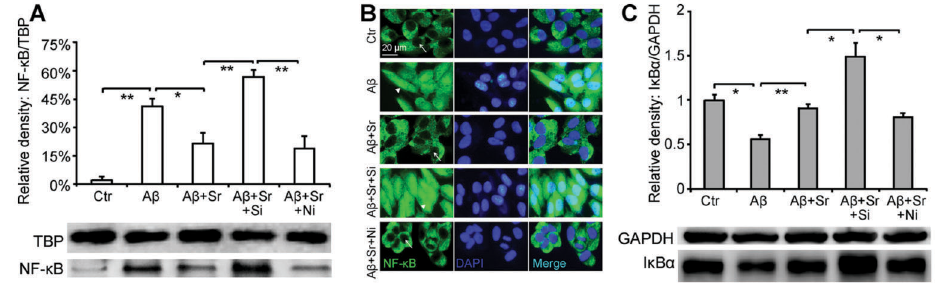
Figure 6. Detection of NF- k B/p65 and I k Ba expression. A , Western blot analysis of NF- k B/p65 expression in the nucleus. B , Immunofluorescence images for nuclear translocation of activated NF- k B/p65 subunit. C , Western blot analysis of I k Ba expression. Exposure to OA b induced a significant increase of NF- k B/p65 protein level in the nucleus and markedly increased nuclear NF- k B/p65 staining. In addition, the protein level of I k Ba was decreased in OA b -stimulated cells. SRT1720 significantly abrogated the effect of OA b on NF- k B/p65 expression or nuclear translocation, and I k Ba expression. Silencing SIRT1 expression by siRNA blocked the inhibitory effect of SRT1720 on OA b -induced NF- k B/p65 expression and activation, but it also significantly increased the protein level of I k Ba. Relative protein expression was quantified by calculating the mean gray density value. Green fluorescence indicates the location of the p65 subunit; nuclei are stained with DAPI (blue). Sr: cells treated with SRT1720; Si: cells transfected with SIRT1 siRNA; Ni: cells transfected with negative control siRNA; TBP: TATA binding protein; GAPDH: glyceraldehyde-3-phosphate dehydrogenase. *P , 0.05, **P , 0.01 (unpaired t -test and